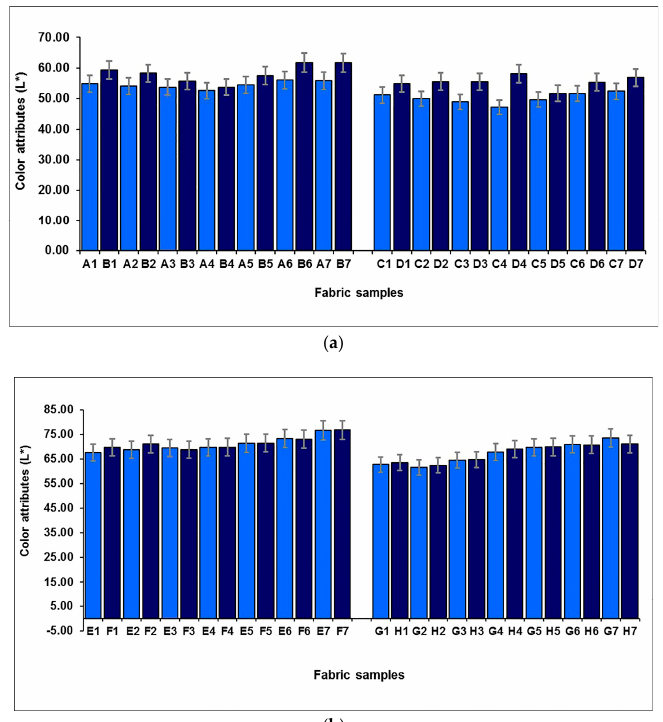
Figure 10. Effect of weft density on the lightness of ( a ) blue-red mixed fabrics; ( b ) yellow-green mixed